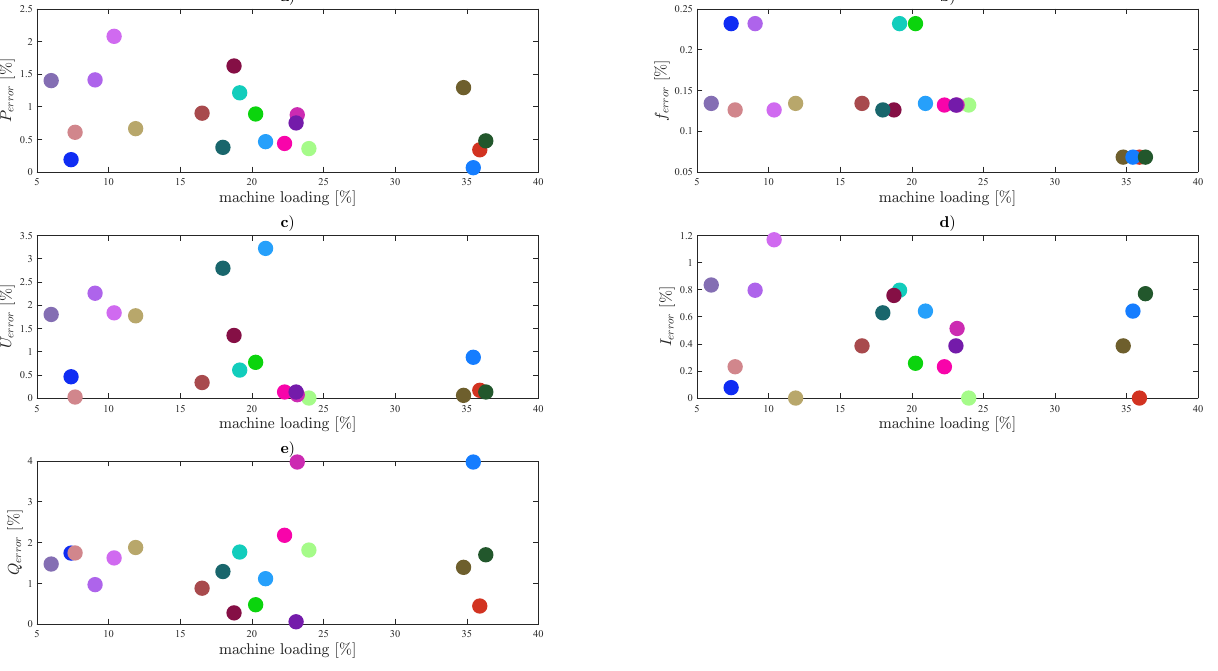
Figure 10. ( a–e ) Errors of the measured signals compared to the simulation output in % depending on the loading of the